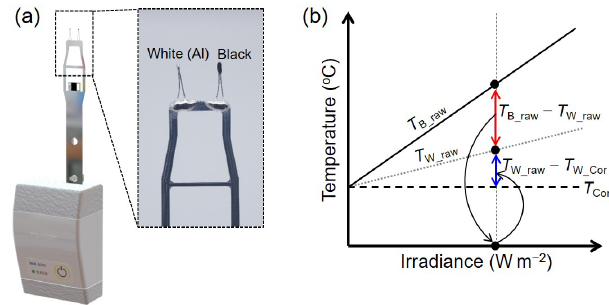
Figure 1. (a) Dual thermistor radiosonde (DTR) with a white and black sensor and (b) operation principle of DTR for irradiance mea- surement and correction of radiation effect based on the measured irradiance. The temperature difference between the dual thermistors ( T B_raw − T W_raw ) is linearly proportional to the irradiance, and the radiation-induced heating of the white sensor ( T W_raw − T W_cor ) is corrected based on the irradiance measured by ( T B_raw − T W_raw